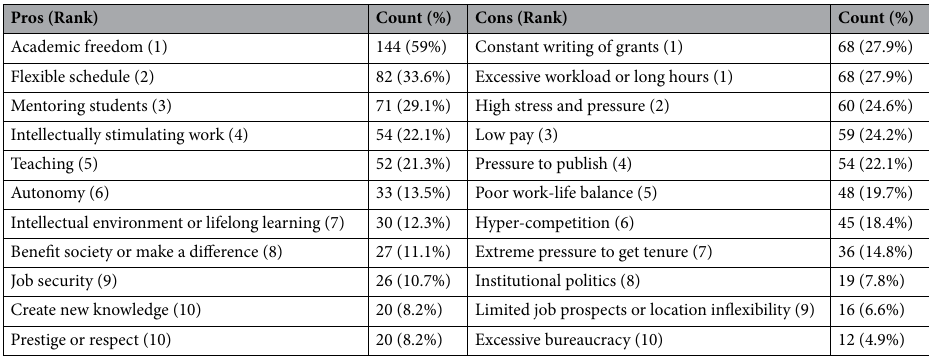
Table 2. Top 10 pros and cons of STEM academia. Ranked in decreasing order by count and